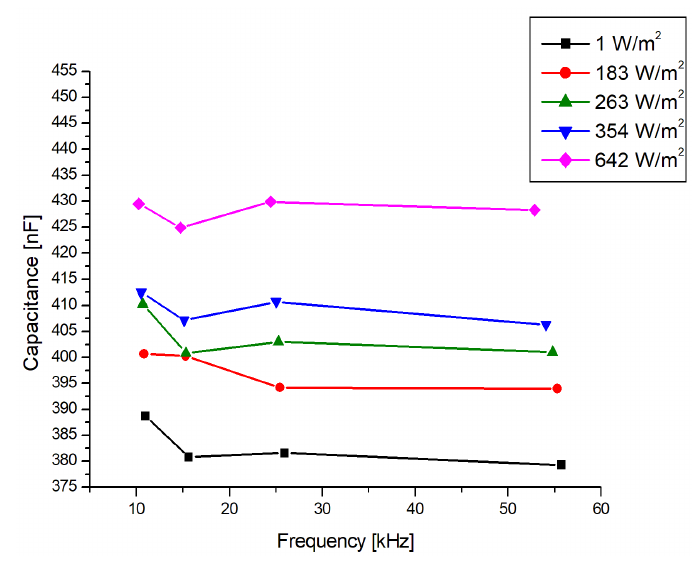
Figure 7. The dependence of the SC capacitance function of the frequency.